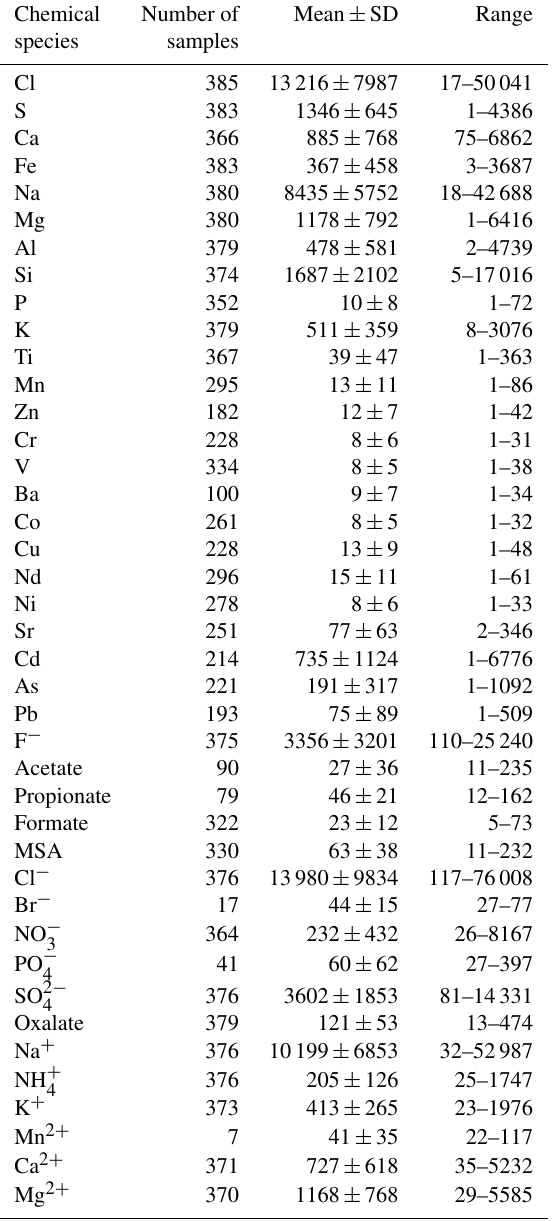
Table 1. Summary statistics of elemental and water-soluble ionic concentrations measured at HBAO. The second column indicates the number of samples for which values were above the minimum quantification limit (MQL). The arithmetic means with standard deviations (SD) and range of mass concentrations (minimum and maximum) are given in ngm − 3